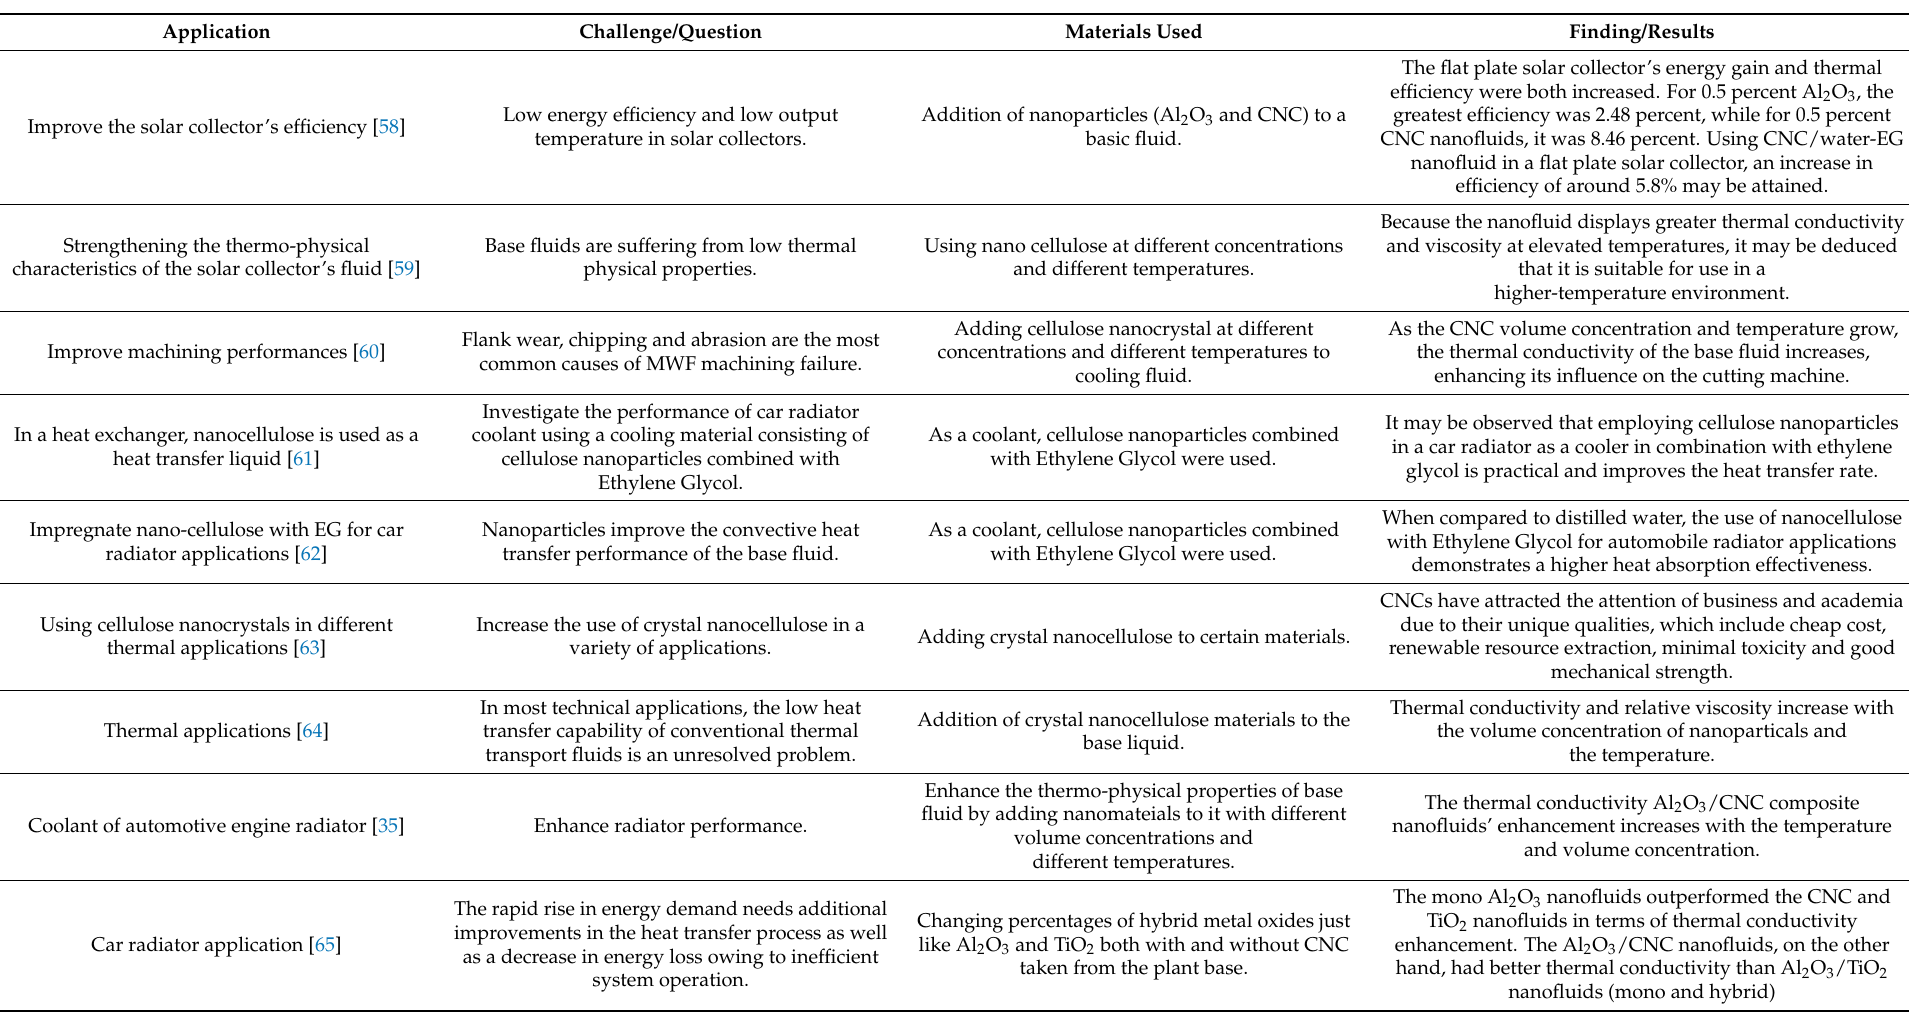
Table 3. Nanocellulose in thermal